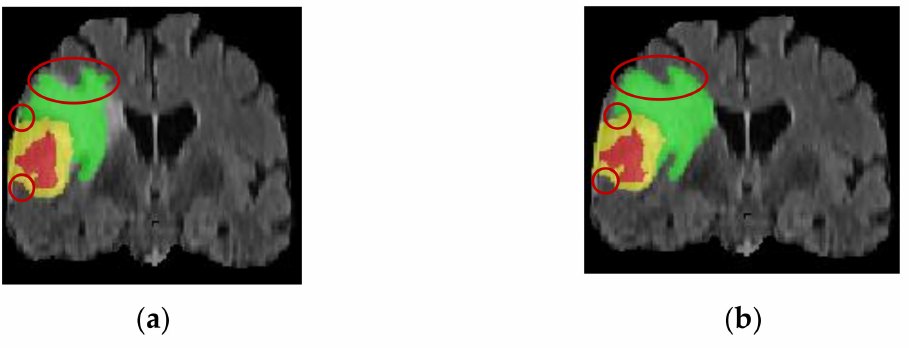
Figure 7. Comparison of the sagittal bit image segmentation results. ( a ) Pre-improvement segmenta- tion; ( b ) Post-improvement